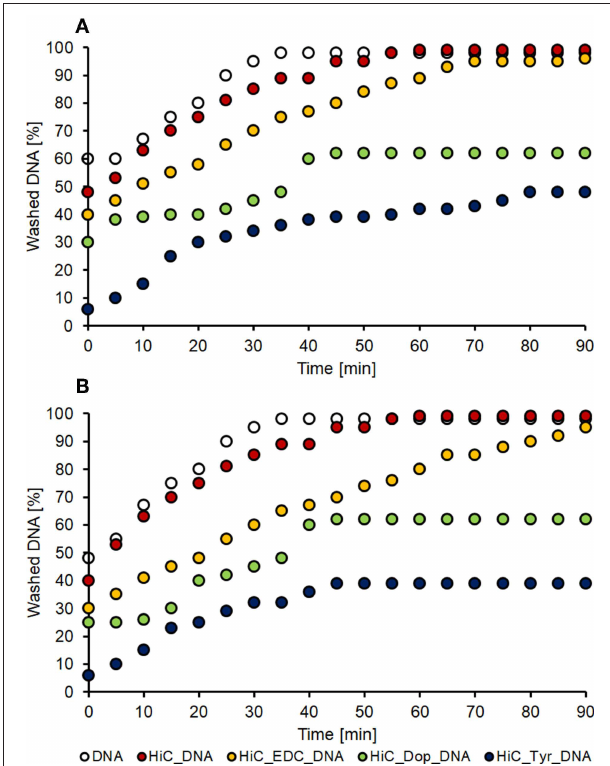
FIGURE 6 | DNA washing stability. Washing of PET (A) and nylon (B) samples treated with DNA absorbed on untreated polymer (white dots), DNA absorbed on enzymatic treated polymer (red dots), and the three coupling conditions: EDC coupling (orange dots), dopamine coupling (green dots) and tyrosine coupling (blue